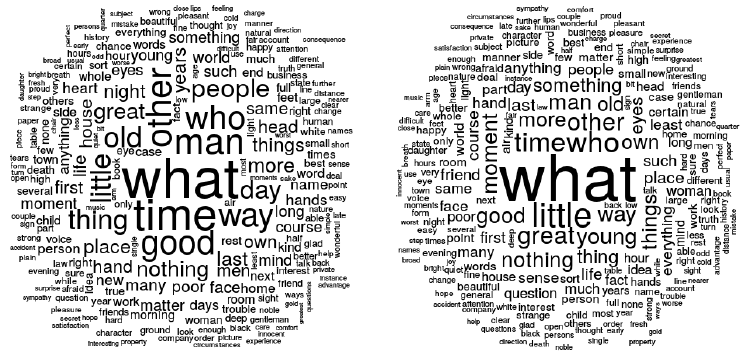
Noun and adjective wordclouds for Twain (left) and James (right), based on their shared constant